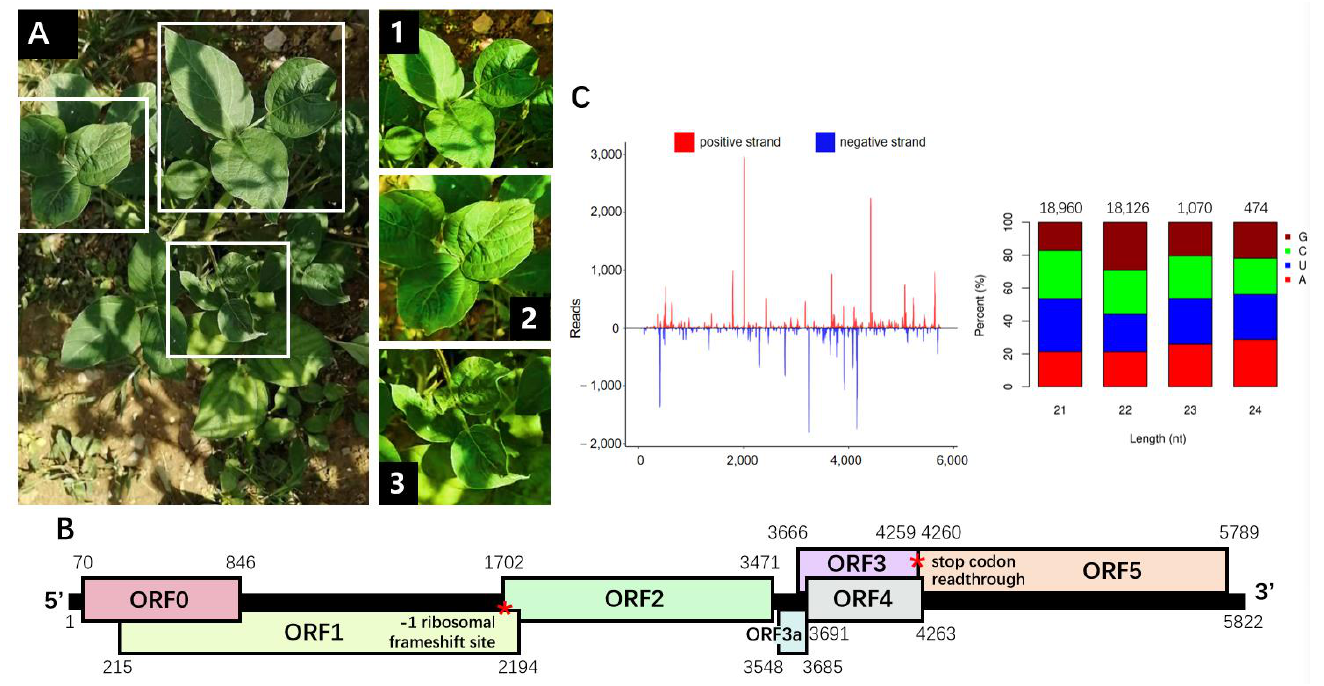
Figure 1. Characterization of the soybean chlorotic leafroll virus (SbCLRV) genome. ( A ) The chlorotic and leafroll symptoms represented on the soybean plant infected by SbCLRV. An overall view of the whole plant. Closer photographs (1, 2 and 3) focus on the symptomatic leaves, which showed curling in all the leaves (1, 2 and 3) and chlorosis in the downward leaves (3). ( B ) Schematic representation of the genomic organization of the SbCLRV. The positions of −1 ribosomal frameshift site in ORF1 and the stop codon for ORF3 readthrough were marked as red asterisks. ( C ) Distribution profile of the vsiRNAs that revealed multiple hotspots along the SbCLRV genome. The red and blue color represent the reads on the viral strand or viral complementary strand, respectively. The 5 (cid:48) -nucleotide bias of the vsiRNAs that matched the SbCLRV genomic sequence has been detailed in the histogram. Histogram bars represent the percentage of each of the four nucleotides, and the color code is detailed in the